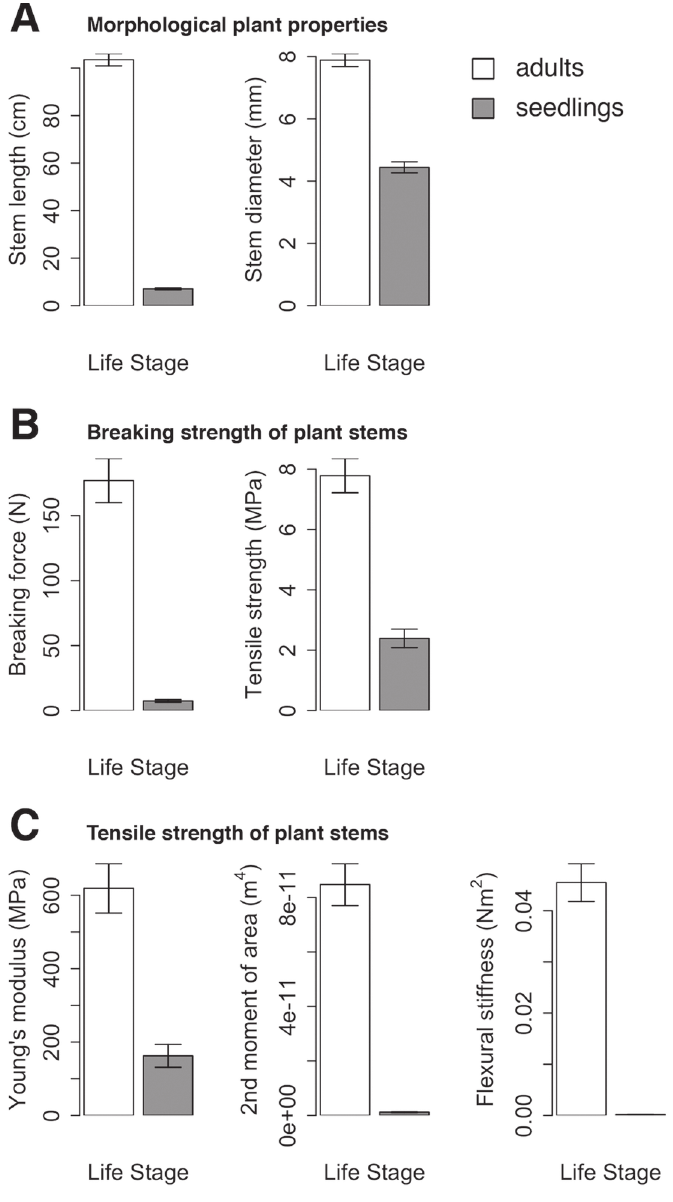
Fig 3. Averages and SE of measured plant traits. A: Morphological plant properties as measured at the moment of transplantation to the flume on 40 adults and 40 seedlings; B & C: Biomechanical traits of stem tissue ( B: Breaking strength; C: Tensile strength) as determined on 20 stems per life